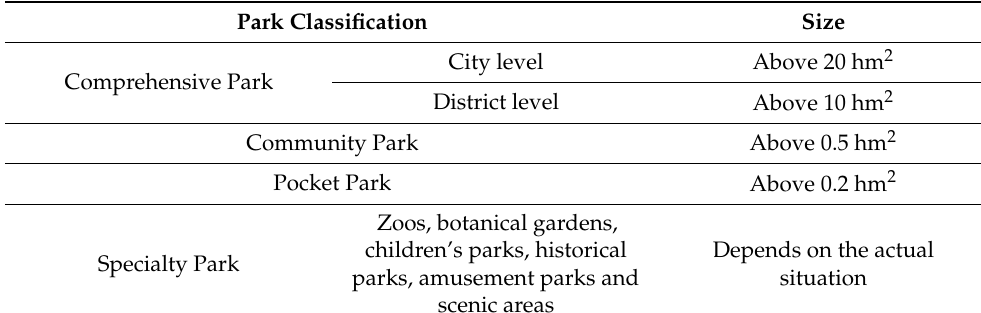
Table 1. Park classification in Yangzhou.